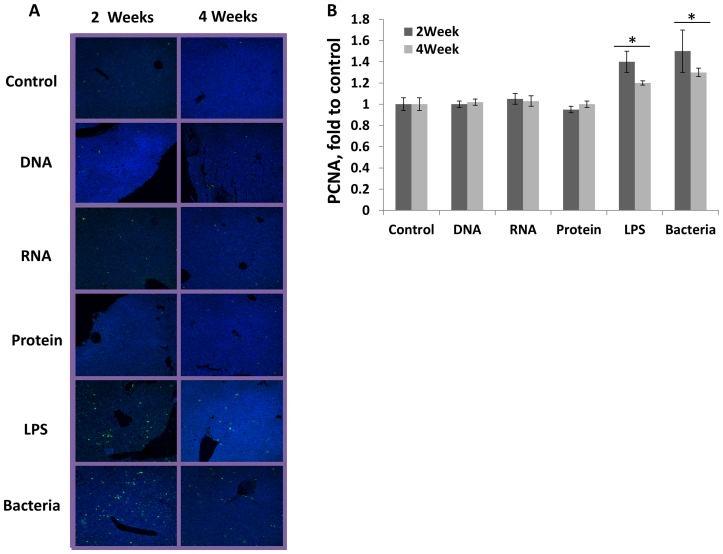
Immunohistochemical analysis of liver tissue samples stained with DAPI staining and Green Fluorescent antibody for PCNA.
A. Images of liver samples taken from individual animals within 2 week and 4 week test groups. B. Quantification of PCNA-positive cells. Bars represent the average (with SD) number of PCNA cells. Asterisks show significant differences from control (p<0.05).